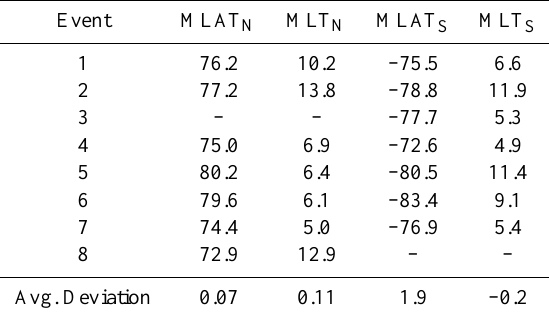
Table 5. Vortex dimensions for both hemispheres in the ionosphere v MSH . at 100km altitude using v ph ≈ 1 2